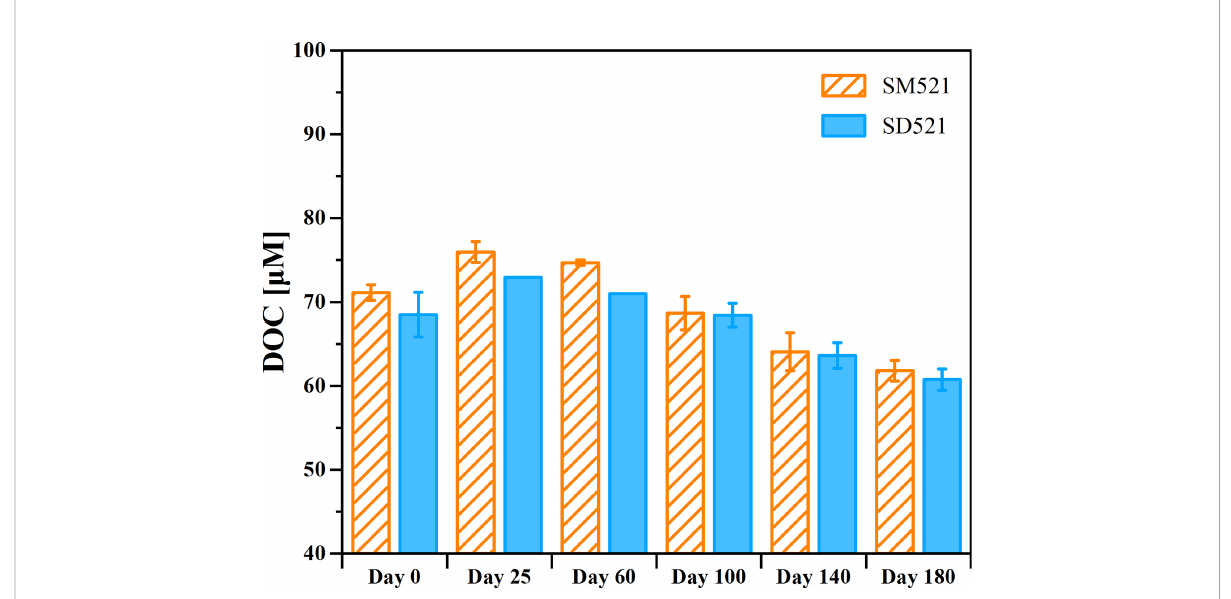
FIGURE 4 Measured DOC concentration changes with time during the two incubation experiments (SM521 and SD521). The error bars denote the means with standard errors from the duplicate